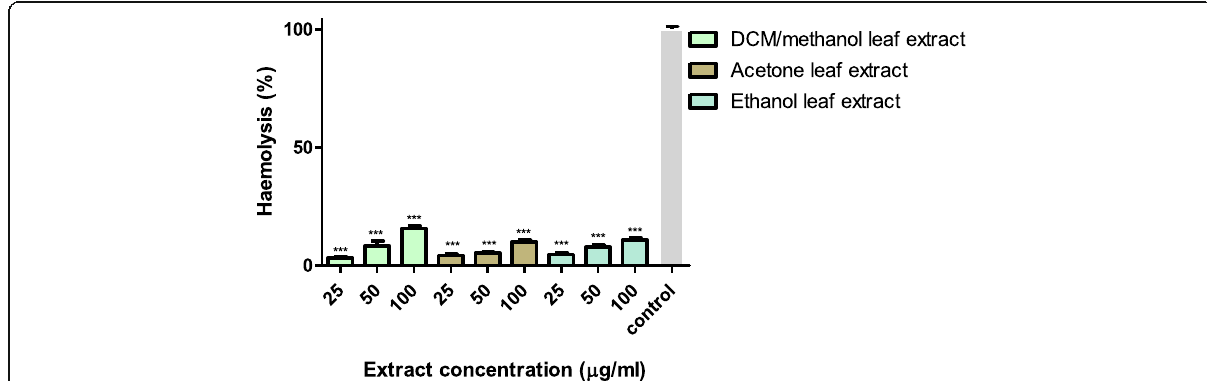
Fig. 5 The percentage haemolysis of sheep erythrocytes induced by exposure to different concentrations of the DCM/methanol, acetone and ethanol leaf extracts from T. welwitschii . Cells with no extract were used as the control. Values are for mean ± standard deviation (error bar) for n = 3. The asterisks indicate a significant difference from the control with *** p <